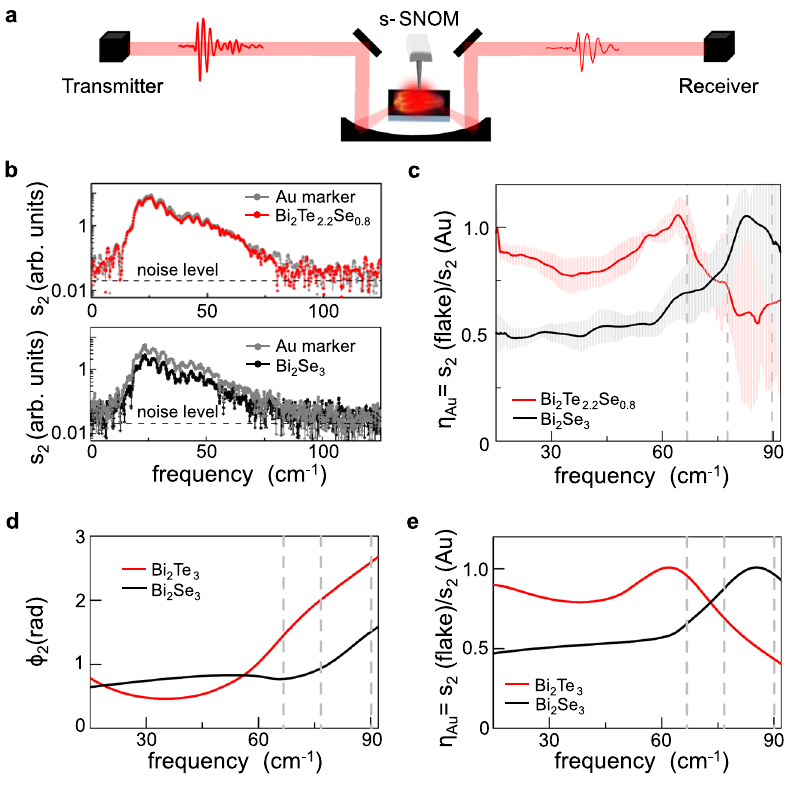
Fig. 1 Hyperspectral THz nano-imaging of TI. a Sketch of the hyperspectral THz nano-imaging experiment based on detection of the THz fi eld forward scattered by the AFM tip of the s-SNOM with a TDS system based on two photoconductive antennas: the receiver and the transmitter. b Spectra of second-order demodulated signal s 2 scattered by thick fl akes of Bi 2 Se 3 (d = 86 nm, lower panel, black circles and line) and Bi 2 Te 2.2 Se 0.8 fl akes (d = 76 nm, upper panel, red circles and line) as compared to the scattered spectra from a 140 nm thick Au reference marker (gray circles and line). c Contrast η Au evaluated dividing the average of 60 spectra s 2 scattered by Bi 2 Te 2.2 Se 0.8 (red line) and Bi 2 Se 3 (black line) by the average of 60 spectra measured on Au reference markers placed near the fl akes after smoothing each curve with the average on 20 points window. The error bars are evaluated as standard deviation. d , e Near- fi eld phase ϕ 2 ( d ) and contrast η Au ( e ) of the second-order demodulated signal s 2 as a function of frequency for bulk Bi 2 Se 3 (black line) and Bi 2 Te 3 (red line) retrieved via numerical inversion 51 of the fi nite-dipole model on a four-layer structure (see Supplementary Fig. 6). Gray dashed lines in panels c – e mark the probing frequencies of the detectorless near- fi eld